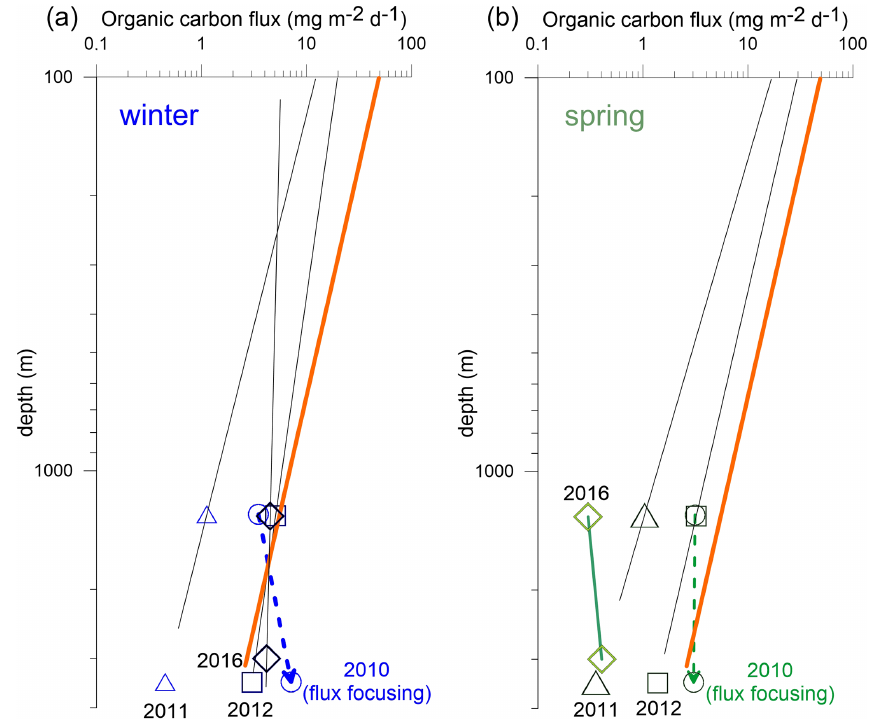
Figure 9. Carbon flux attenuation (log–log plot) in the water column during winter (a) and spring (b) for 2010 (extremely low oxygen ACME), 2011 (oligotrophic situation), 2012 and 2016 (ACME). Attenuation according to Martin et al. (1987; with b = − 0 . 858, orange line) is shown. Note a more reduced carbon flux attenuation than that predicted by the Martin curve during the winters 2010, 2012 and 2016, when low-oxygen and low-salinity eddies passed. During the extreme winter 2010 ACME, deep-ocean fluxes increased strongly with depth (also in spring) due to flux focusing (arrows; Fischer et al., 2016). Fluxes more typical of oligotrophic conditions and carbon flux attenuation occurred in winter and spring